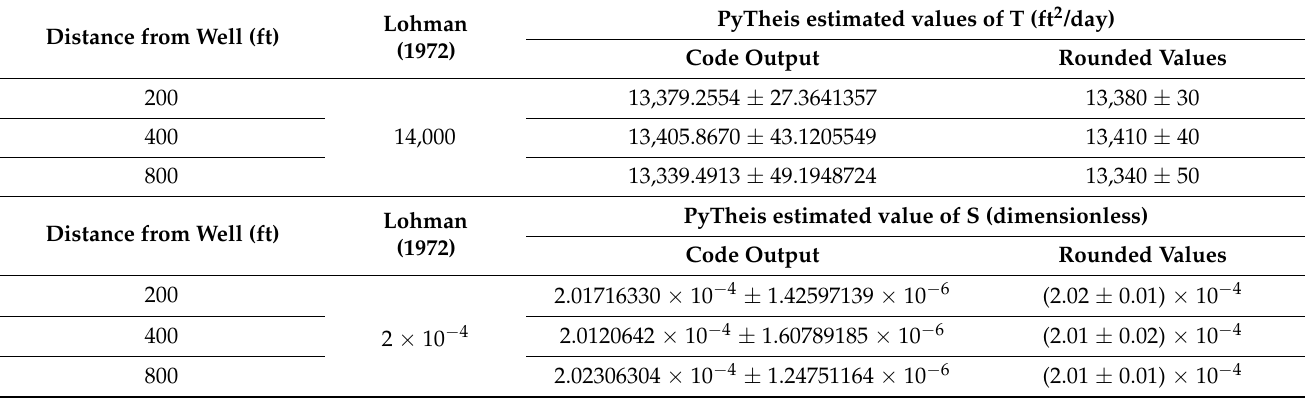
Distance from Well